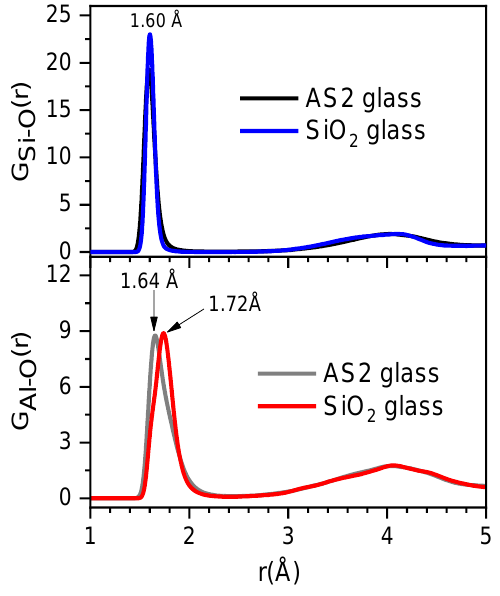
Figure 5. The θ O─Si─O bond angle and Si─O bond distance distribution in SiO 4 , SiO 5 units of the pure SiO 2 and AS2 glasses